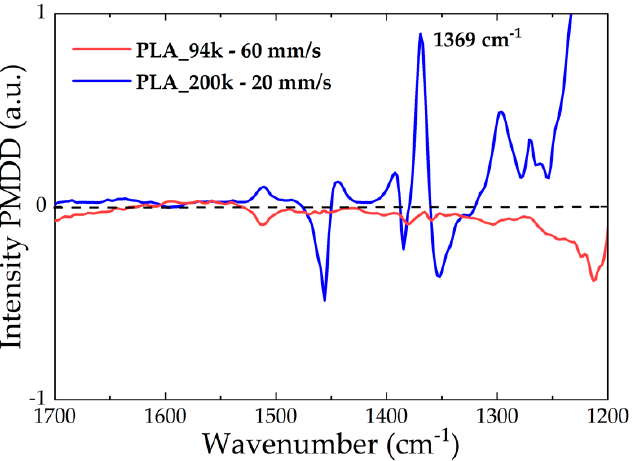
Figure 6. Comparison of the PMDD spectra acquired for PLA_4_200k printed at 20 mm/s and PLA_0_94k printed at 60 mm/s.